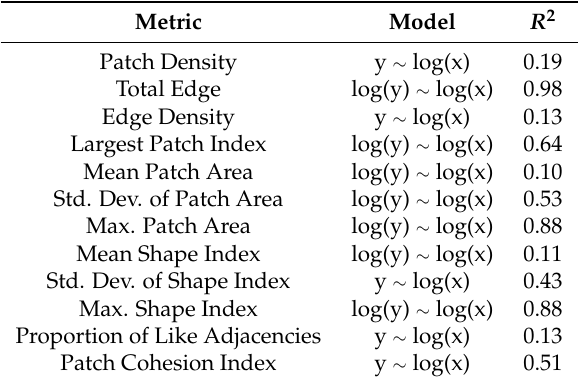
Table 4. Best fit models for metric (y) by dominant length scale (x).